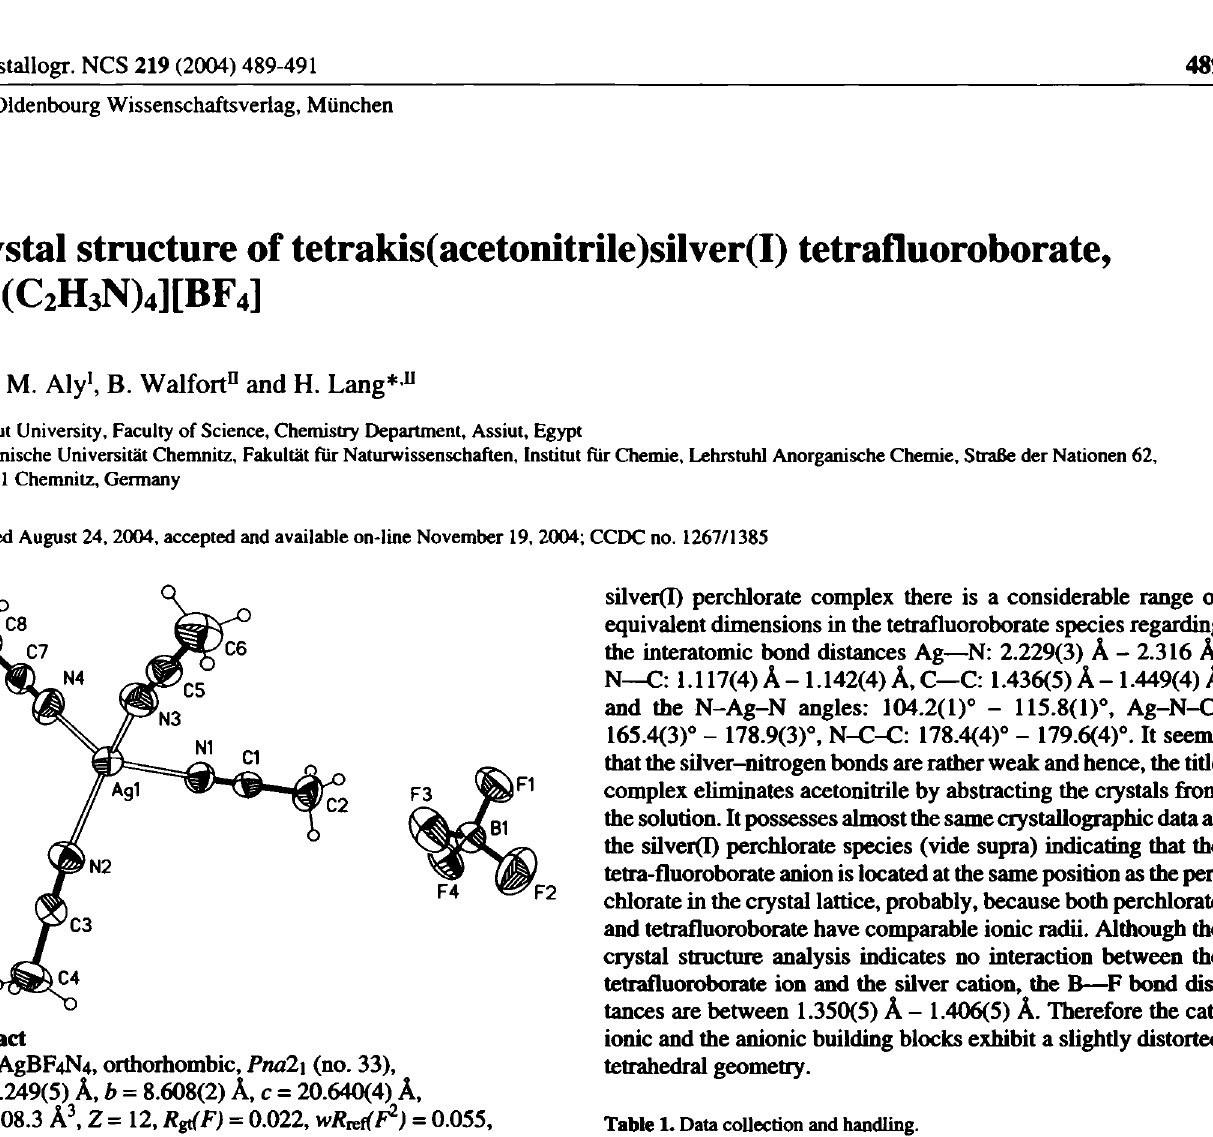
Table 1. Data collection and handling.